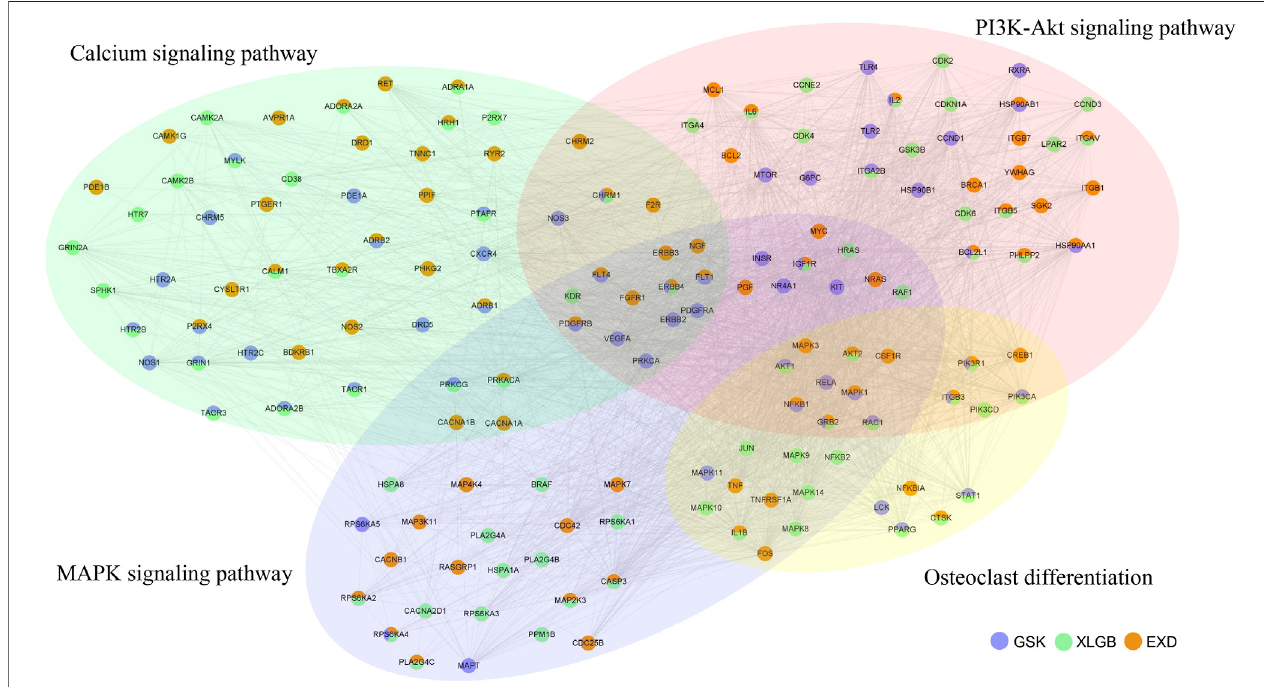
FIGURE 10 | Gene network in the osteoclast differentiation, calcium signaling pathway, MAPK signaling pathway, and PI3K-Akt signaling pathway. Blue nodes represent targets in GSK. Green nodes represent targets in XLGB. Orange nodes represent targets in EXD. Nodes with three colors indicate that the gene is shared by three prescriptions. Nodes in light yellow, light green, light blue, and light red circles represent genes of osteoclast differentiation, calcium signaling pathway, MAPK signaling pathway, and PI3K-Akt signaling pathway, respectively.